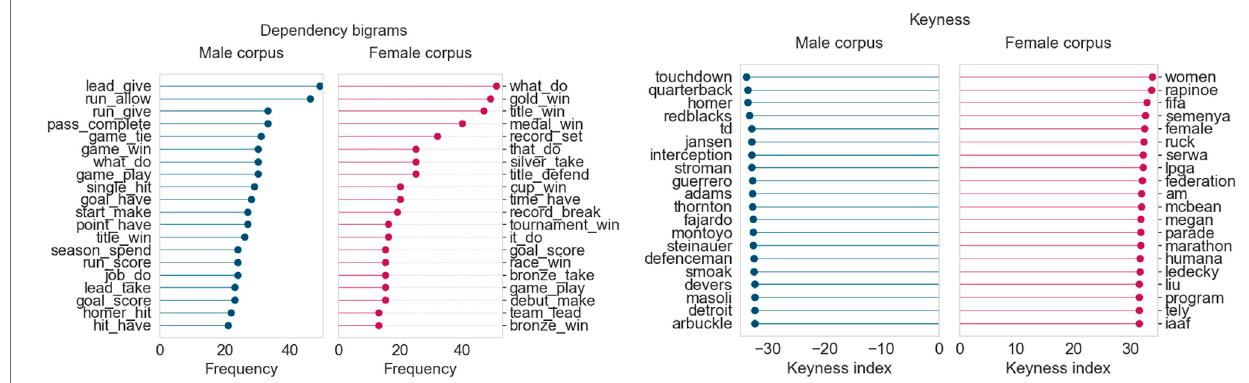
FIGURE 5 | Corpus analysis results for top 200 articles from “ Sports ” (July 2019).